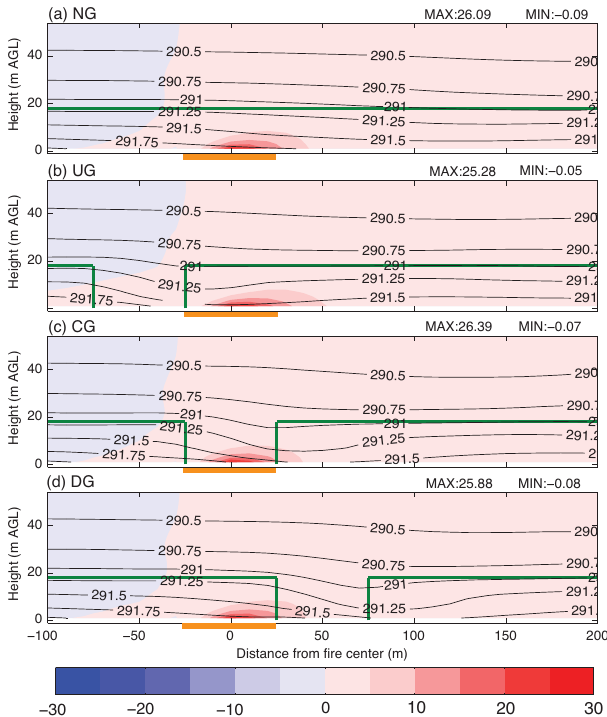
Figure 5. As in Fig. 2 but for temperature (K); contour interval is 0.25K, and shading interval is